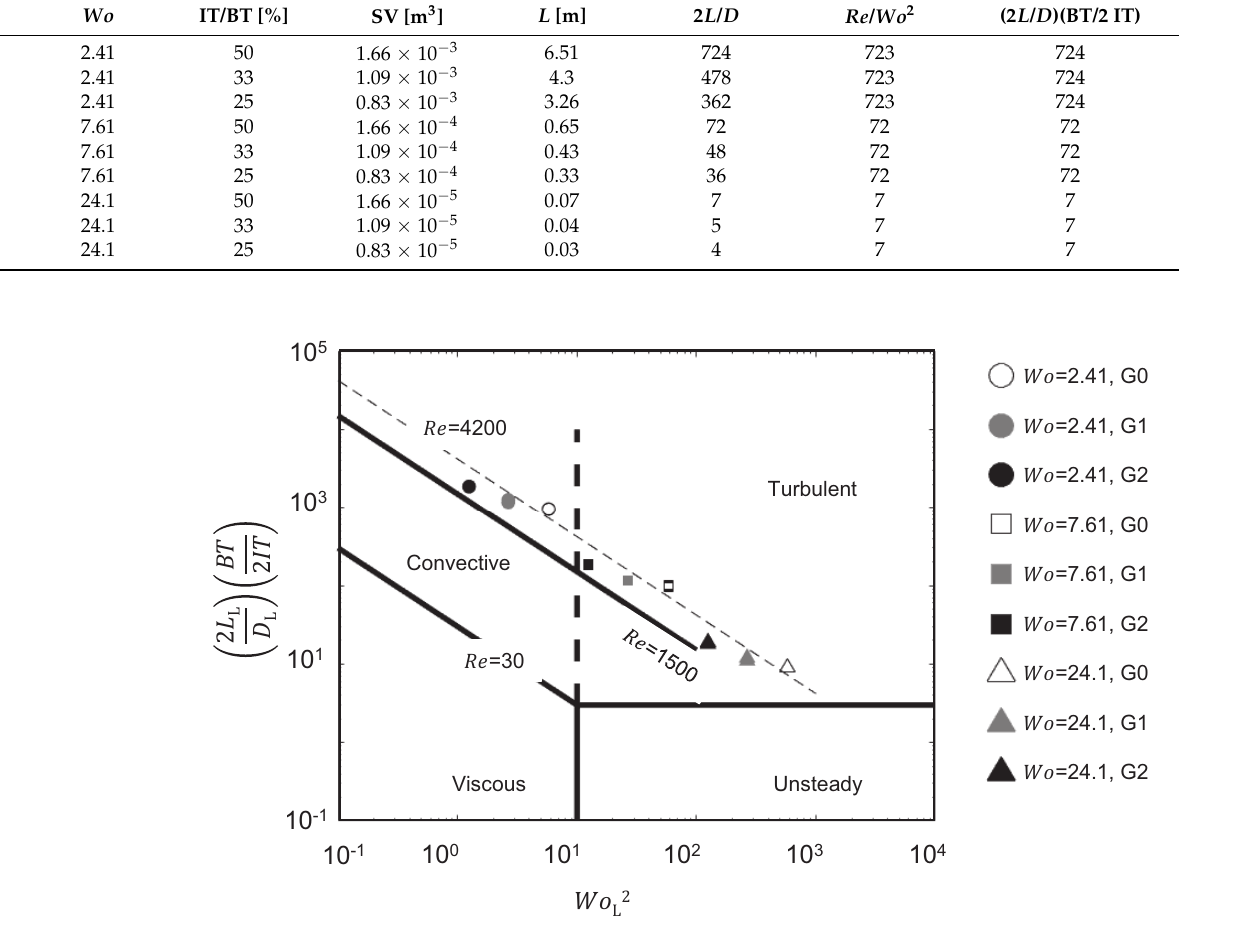
Figure 16. Modified regime diagram (originally proposed by Jan et al. [3]) for classifying the flow at the planes identified in Table 2, interrelating the local Womersley number and modified stroke